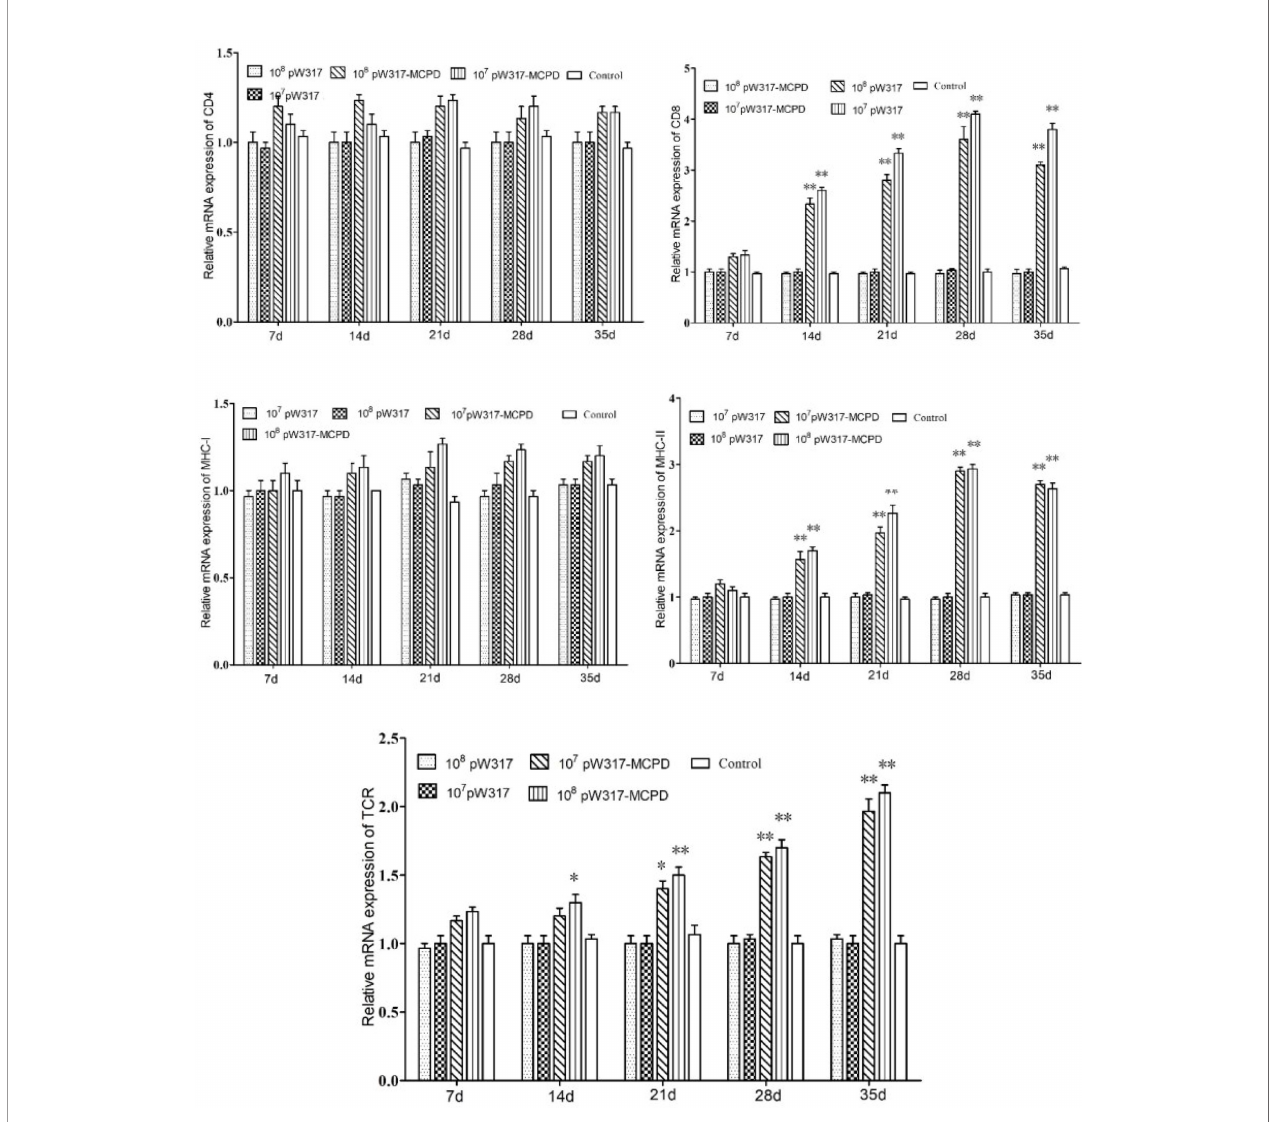
FIGURE 5 | The expression level of antigen presentation-related gene in gut after immunization. 10 7 pW317: 10 7 CFU/g GS115-pW317; 10 8 pW317: 10 8 CFU/g GS115-pW317; 10 7 pW317-MCPD: 10 7 CFU/g GS115-pW317-MCPD; 10 8 pW317-MCPD: 10 8 CFU/g GS115-pW317-MCPD. **P < 0.01; *P <